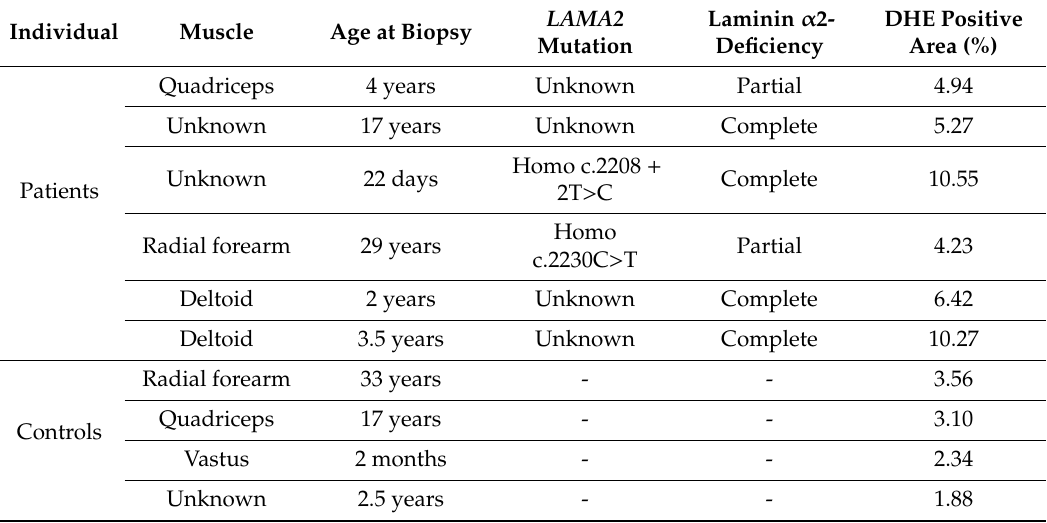
Table 1. Details of control individuals and patients including biopsy site, age at biopsy, the size of dihydroethidium (DHE)-positive areas in percentage of total section